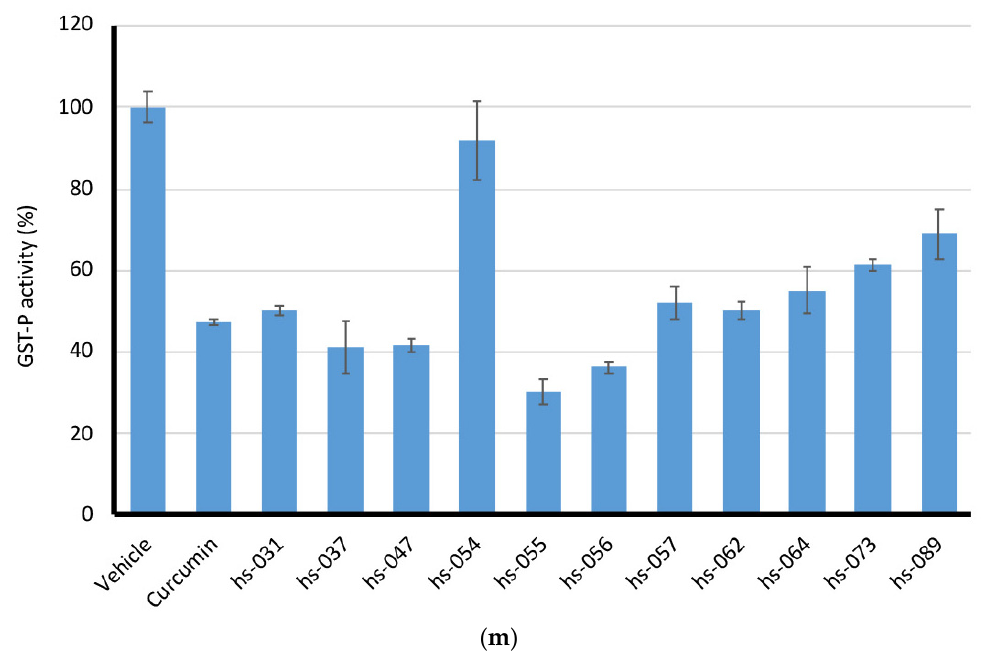
Figure 7. Predicted binding sites of curcumin on ROS metabolic enzymes, ( a ) CBR1, ( b ) GST-P1, ( c ) NQO1, ( d ) PRDX1, ( e ) AKR1C1, ( f ) NQO2, and ( g ) GLO1. The ROS metabolic enzymes are shown in the surface model. The residues are colored by maroon gradation according to their propensity for ligand binding. The bound co-enzymes (NADPH, FAD, and NADP) or substrate/substrate analog (GSH and NBC-GSH) are shown in sphere models colored in blue. ( h , i ) Competitive pulldown assay between cell lysates containing HA-CBR1 ( h )/HA-GSTP1 ( i ) proteins and curcumin derivatives-beads in the presence and absence of 10 mM NADPH ( h ) and 10 mM glutathione ( i ). Bound proteins were visualized by immunoblotting, using an anti-HA antibody. ( j – m ) CBR1 ( j ) and GST-P1 ( l ) enzymatic activities was measured in vitro in the presence of curcumin derivatives. The IC 50 of the compounds is shown as the mean ± SD ( n = 3). CBR1 ( k ) and GST-P1 ( m ) activities in the presence of curcumin derivatives (50 μ M) are shown as the mean ± SD ( n = 3).